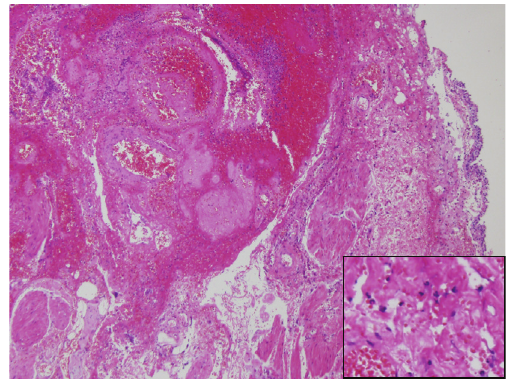
Figure 2: Histology of bladder specimen excised during laparotomy showing edema, bleeding, and granulocyte infiltration.